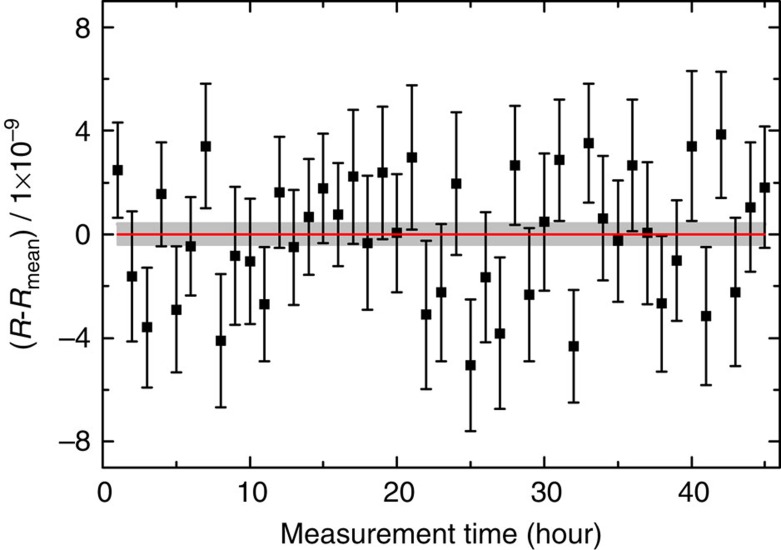
Data sets of the cyclotron-frequency ratio measurements R1 h of 48Ca+ and 12C4+ at SHIPTRAP.The red line and the grey-shaded band illustrate the mean ratio Rmean and the s.d. For details on the plotted error bars see text.